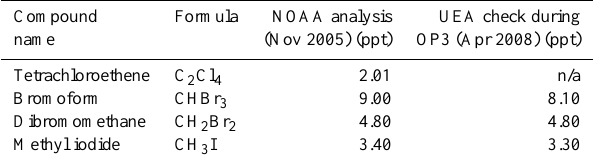
Table 2a. Calibration mixing ratios of C 2 Cl 4 , CHBr 3 , CH 2 Br 2 and CH 3 I used for quantifying our data from Bukit Atur and Tawau. Calibration data for (a) the high-quality NOAA SX-3542 cylinder based at Tawau; (b) data for the cylinder containing de- canted NOAA cal gas (from AAL-70424) based at Bukit Atur